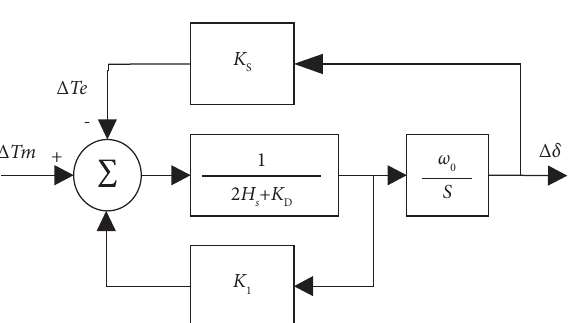
Figure 2: Control framework of single-machine infnite bus system.